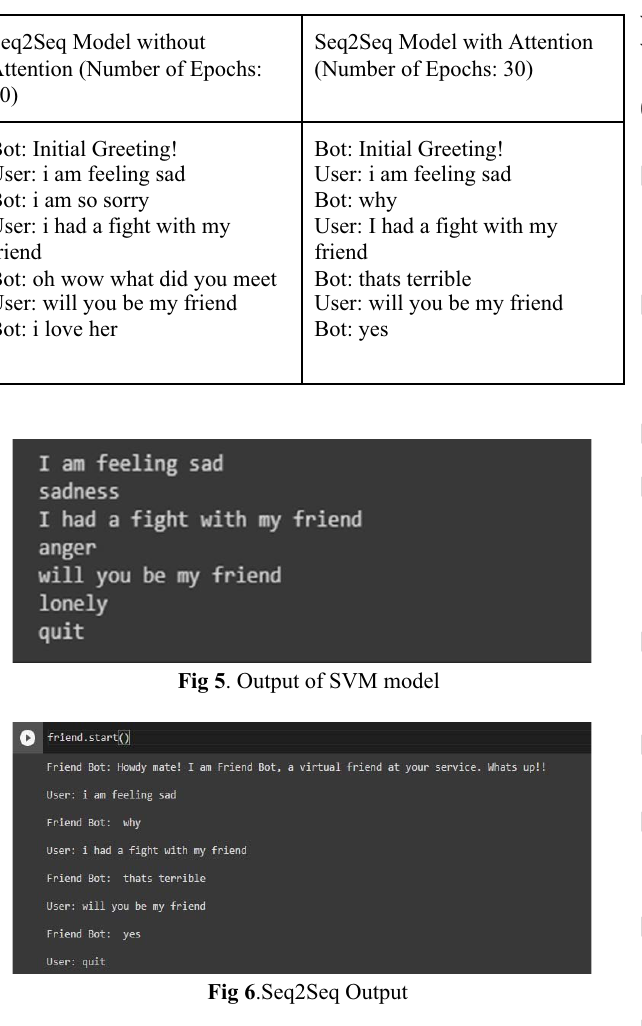
Table 2: Comparison of model with and without Attention